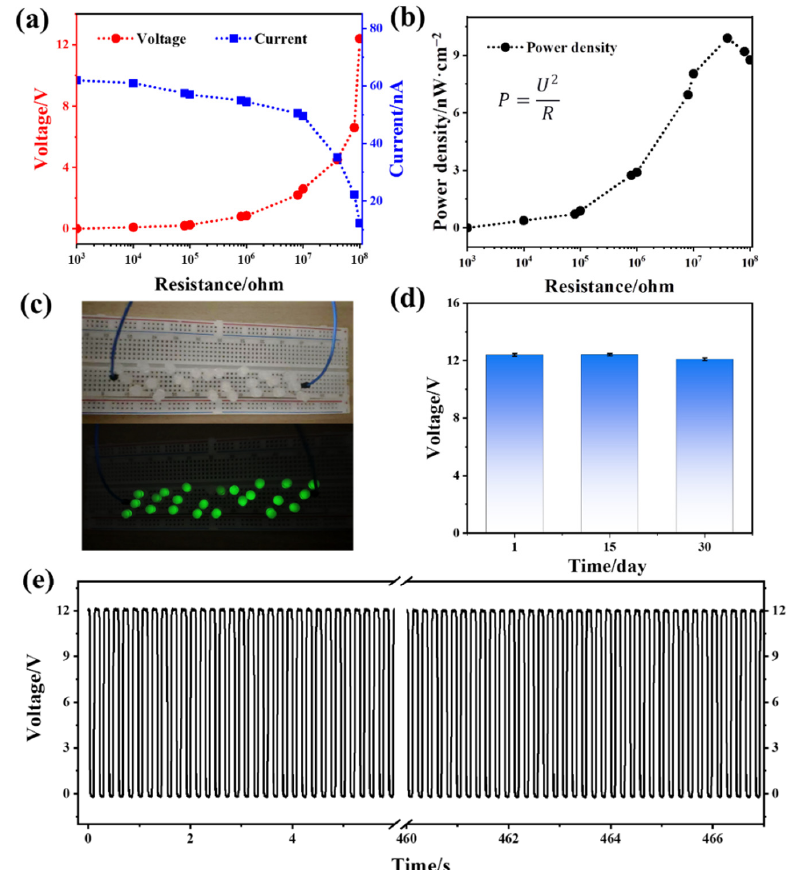
Figure 11. PDOTES-paper-based TENG: ( a ) Output voltage and current changes under external resistance; ( b ) power output curve under external resistance; ( c ) demonstrating supply of current to an LED lamp; ( d ) output performance vs. time; ( e ) output performance after 2000 cycles.